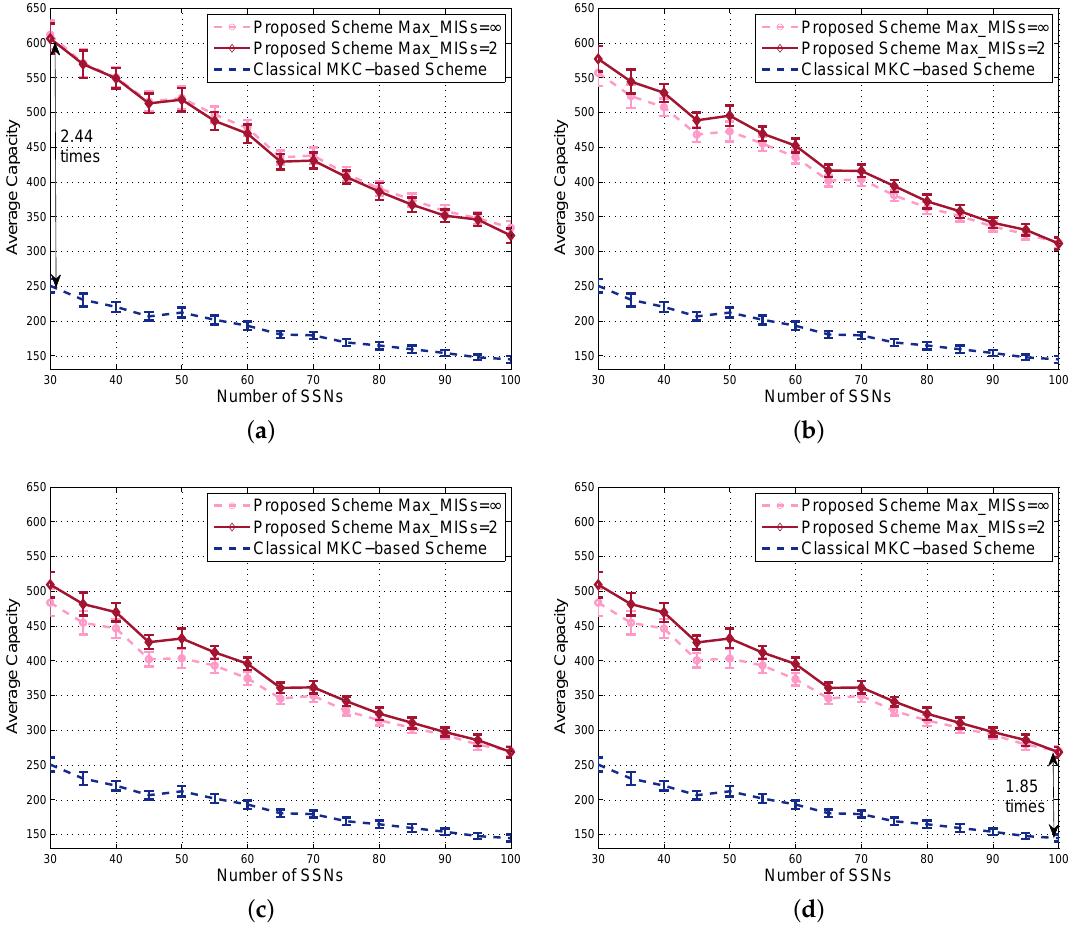
Figure 10. Comparison of capacity in dense scenarios: ( a ) α = 0; ( b ) α = 0.4; ( c ) α = 0.8; ( d ) α =